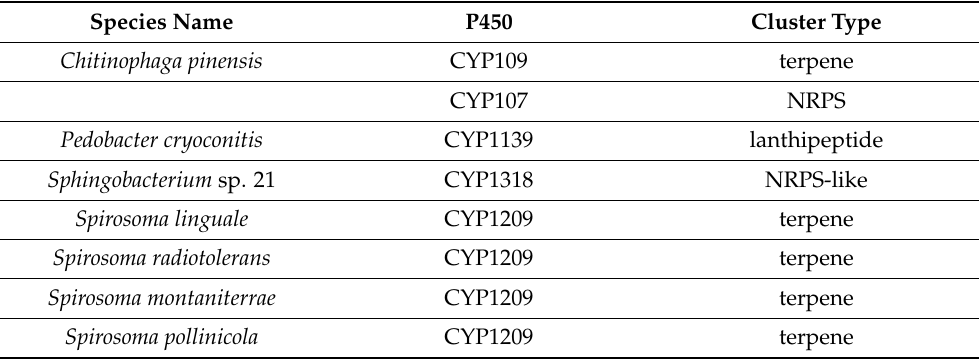
Table 4. Comparative analysis of P450s involved in secondary metabolism in Bacteroidetes species. The cluster type names/abbreviations used in the table are the standard abbreviations proposed by anti-SMASH